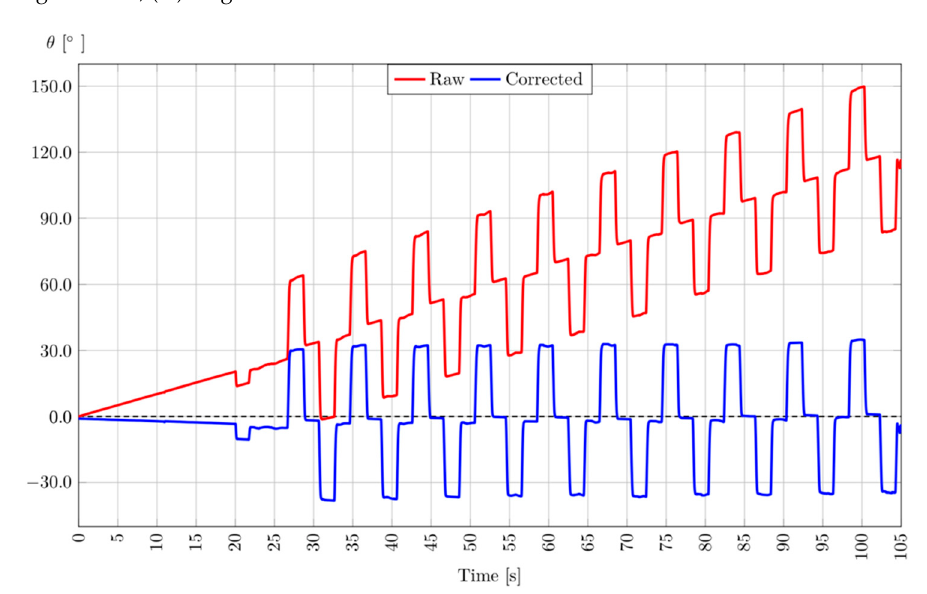
Figure 5. Example of linear drift due to integration of DYSKIMOT’s raw angular velocity (red line) and correction of the drift of the test angle Z with the servo motor (blue line). The corrected angle (blue line) is obtained by subtraction of the regression line to the raw angle. This plot has been obtained by fixing the DYSKIMOT sensor on a servo motor (MG995, Tower Pro) performing successive and opposite rotations of amplitude 30°.